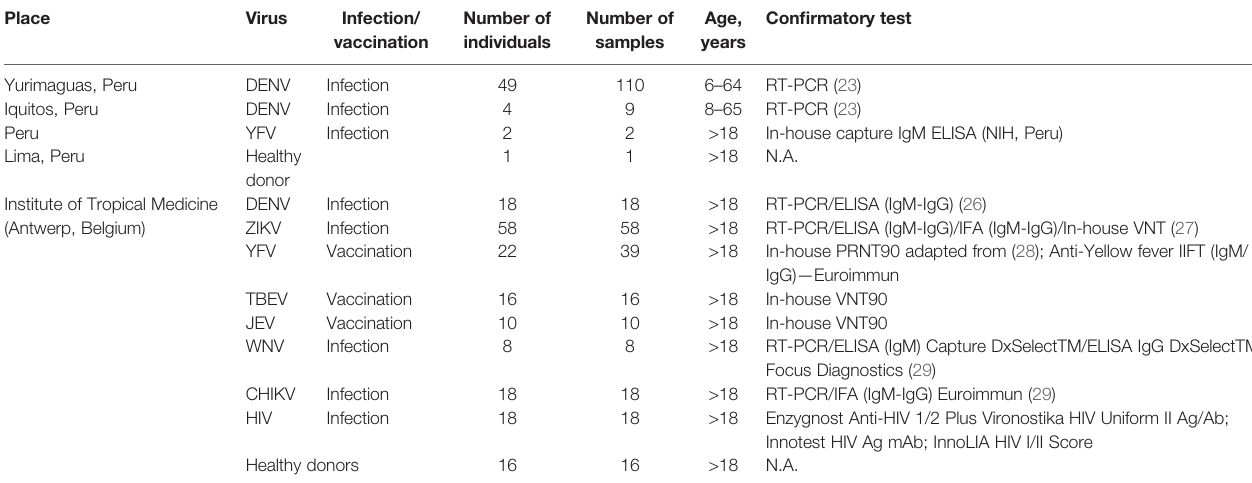
TABLE 1 | Overview of samples used in the study. Place